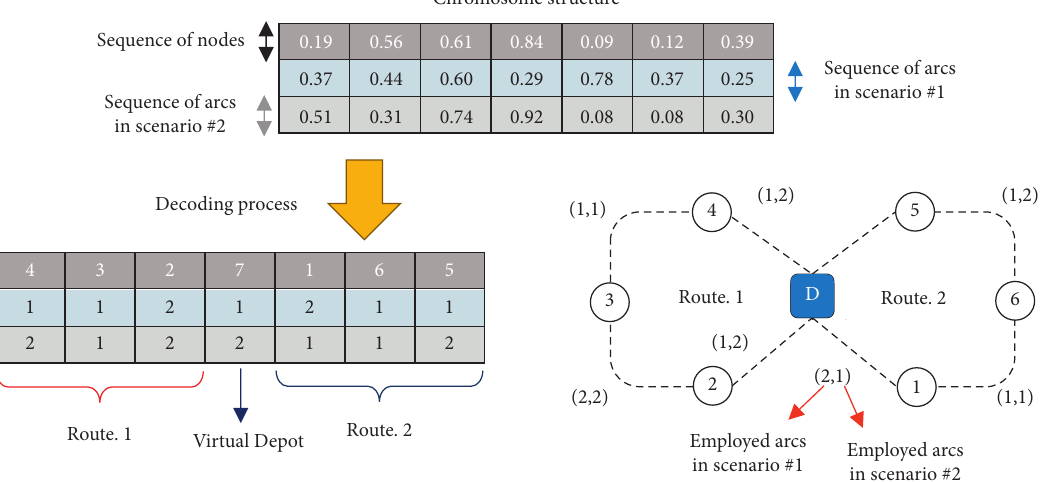
Figure 5: Solution representation and decoding